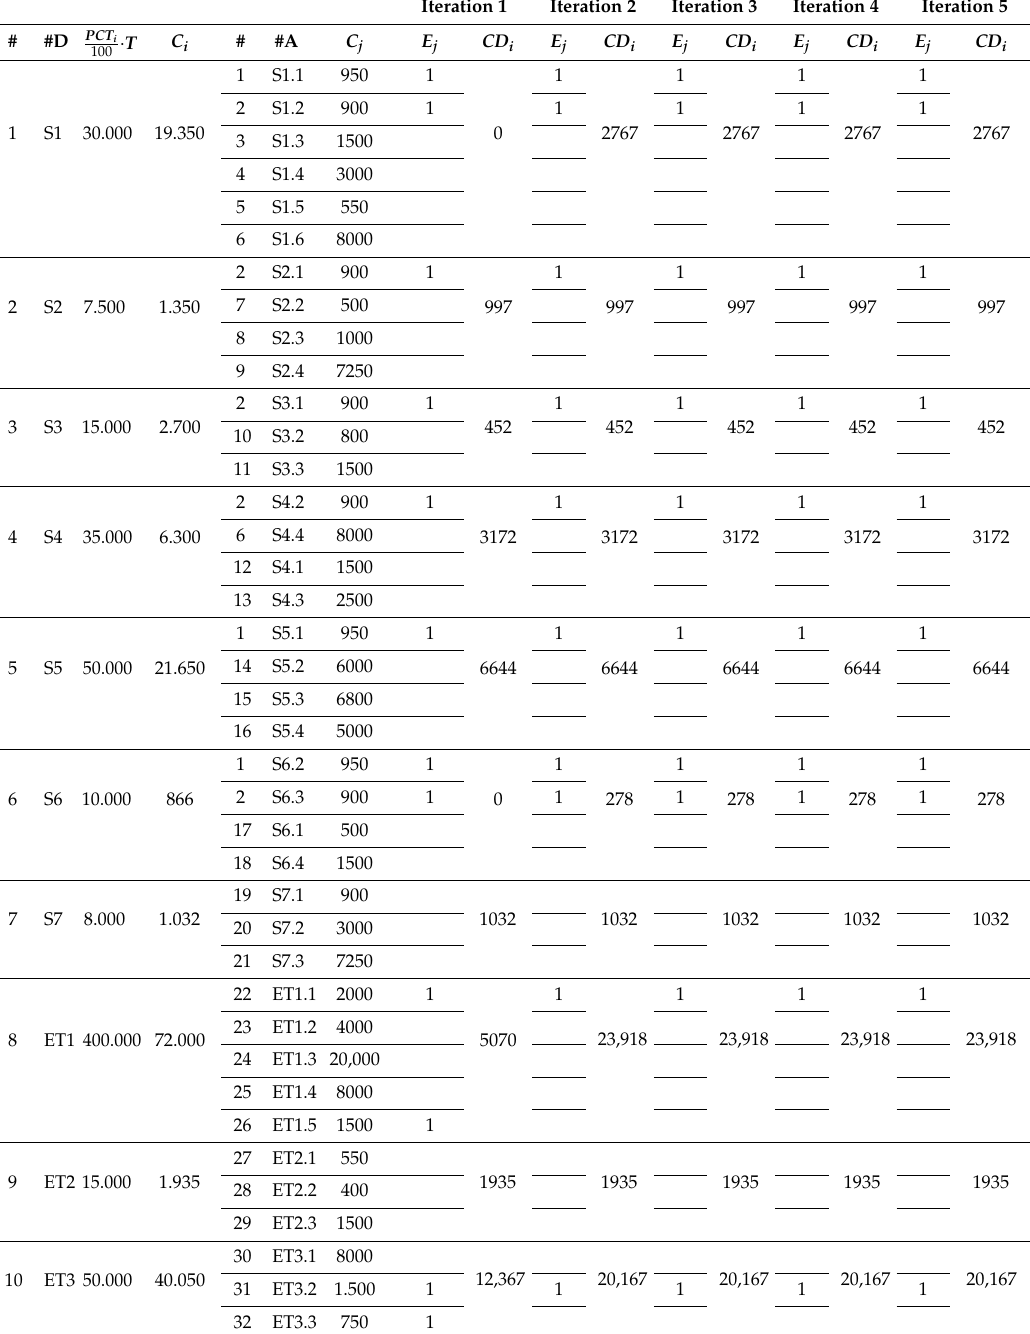
Table 11. Input data and results of analysis of preparedness capacity of enterprise resilience (costs are in €